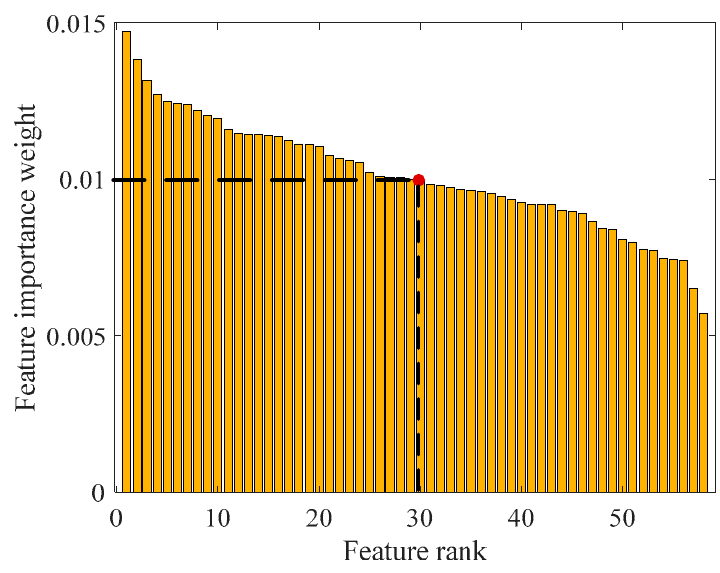
Figure 7. Training accuracy and loss graphs of the R-CNN+LSTM model.